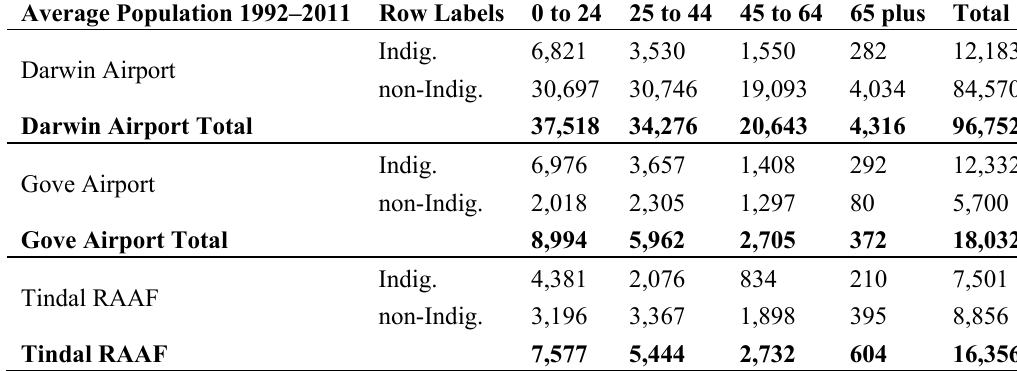
Table 1. Indigenous and non-Indigenous populations in each weather station region and age category averaged over the time period of the admissions